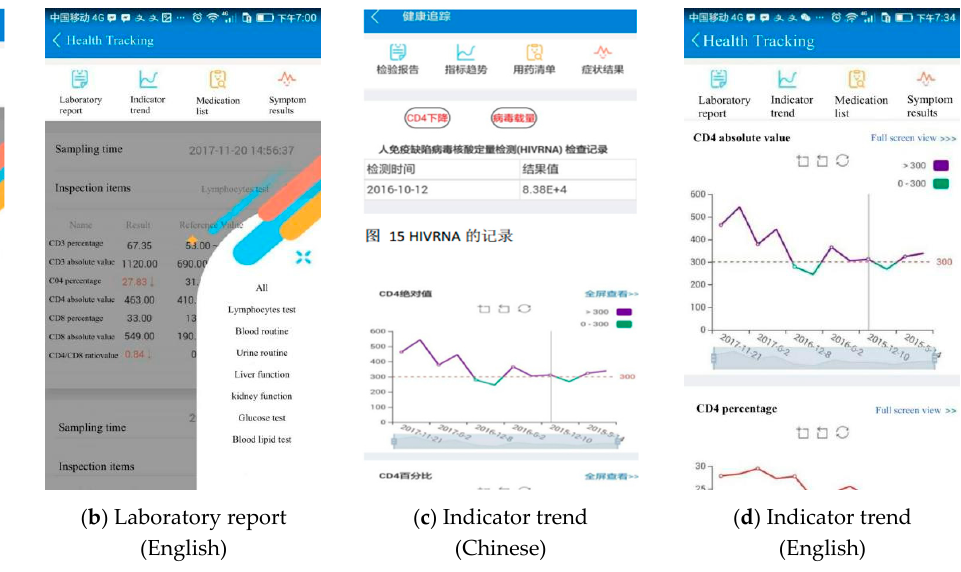
Figure 6. Screenshot of laboratory report and indicator trend.